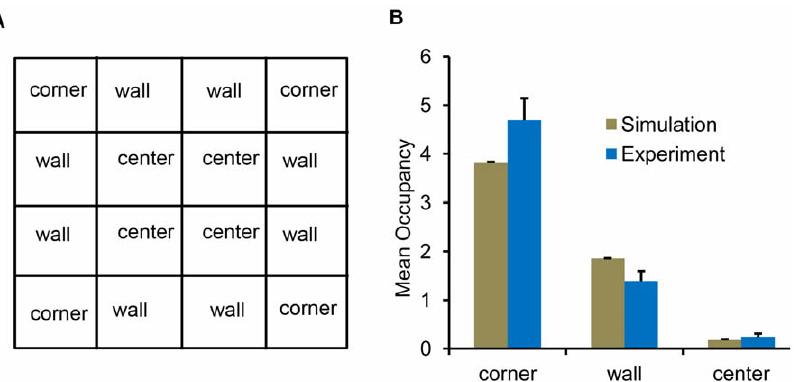
Figure 3. Mean occupancy in different zones of 4.2 cm circular arena with internal corners. A. The internal corner arena was constructed with a cross placed in the center of a 4.2 cm circular arena. We considered two zones in this arena: cross and edge zone. The cross zone was a 4 cm 2 square sector positioned at the center while the edge zone was a annular region of width 0.6 cm along the boundary. B. The mean occupancies of the flies, both from simulations and experiments, in each zone are shown. The times spent in these zones by Drosophila were statistically similar to that from the two-component model. Drosophila showed a preference for the boundary over internal corners.